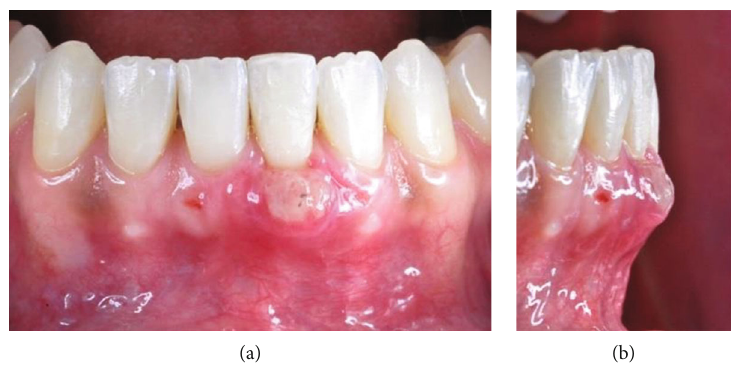
Figure 12: (a, b) Ten days postoperatively.